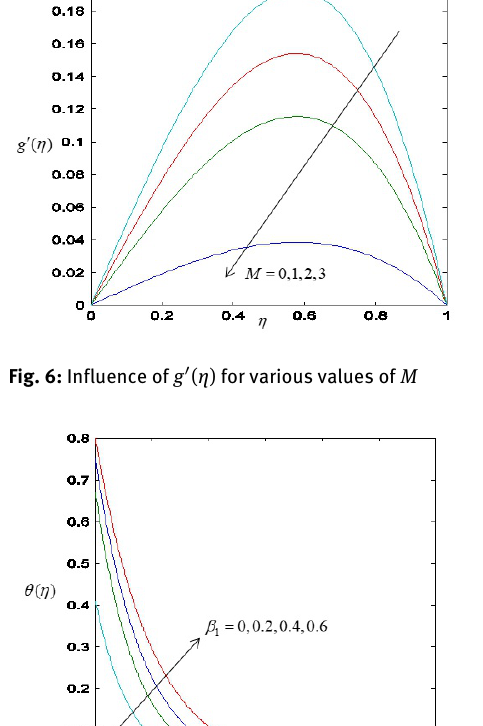
Fig. 8: Influence of Deborah number in terms of relaxation time β 2 on θ ( η )